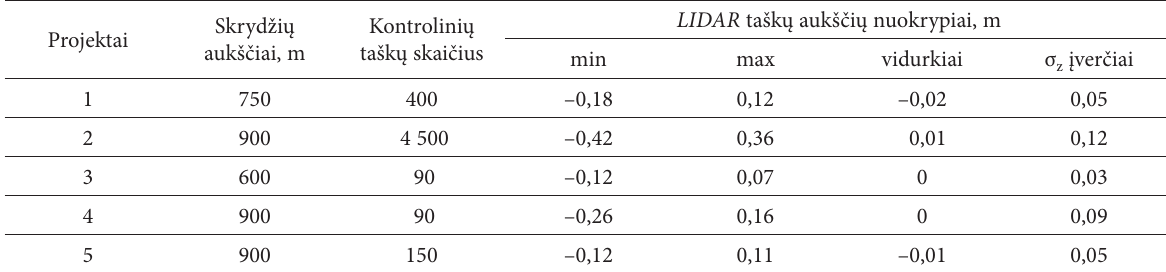
Table 1. Results of Airborne 1 Corporation investigation of LIDAR vertical accuracy LIDAR taškų aukščių nuokrypiai, m Skrydžių Kontrolinių Projektai aukščiai, m taškų skaičius min